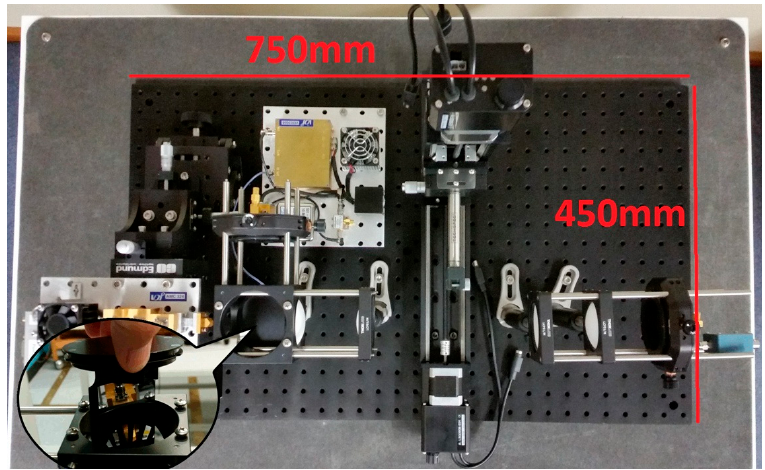
Figure 2. A view of the full system mounted on a portable optical plate (450 mm × 750 mm) showing a linearly aligned source-lenses-sample-detector scheme and a removable beam splitter (inset) for changing between transmission and reflection mode.